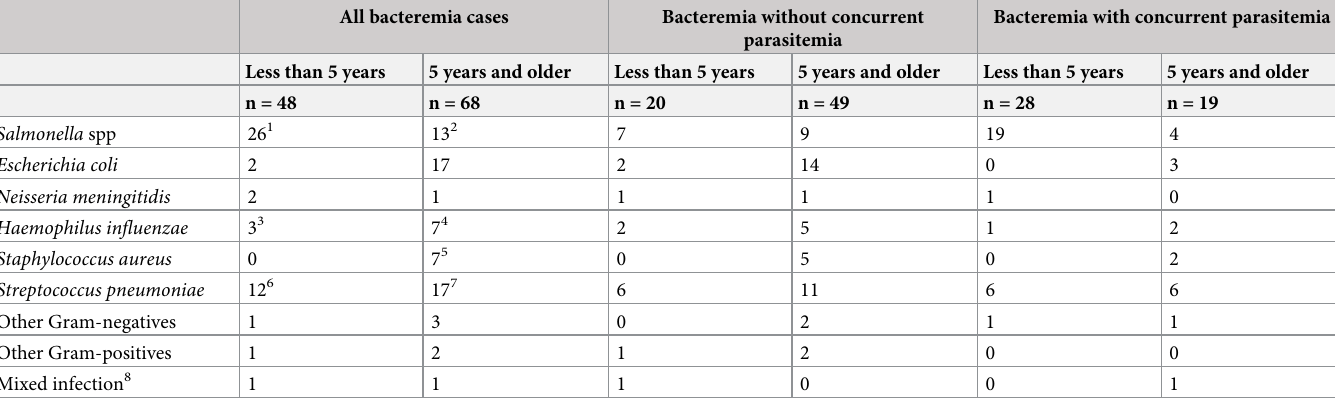
Table 2. Overview of pathogens causing bacteremia in those with- and without concurrent malaria parasitemia (n = 116). All bacteremia cases Bacteremia without concurrent Bacteremia with concurrent parasitemia